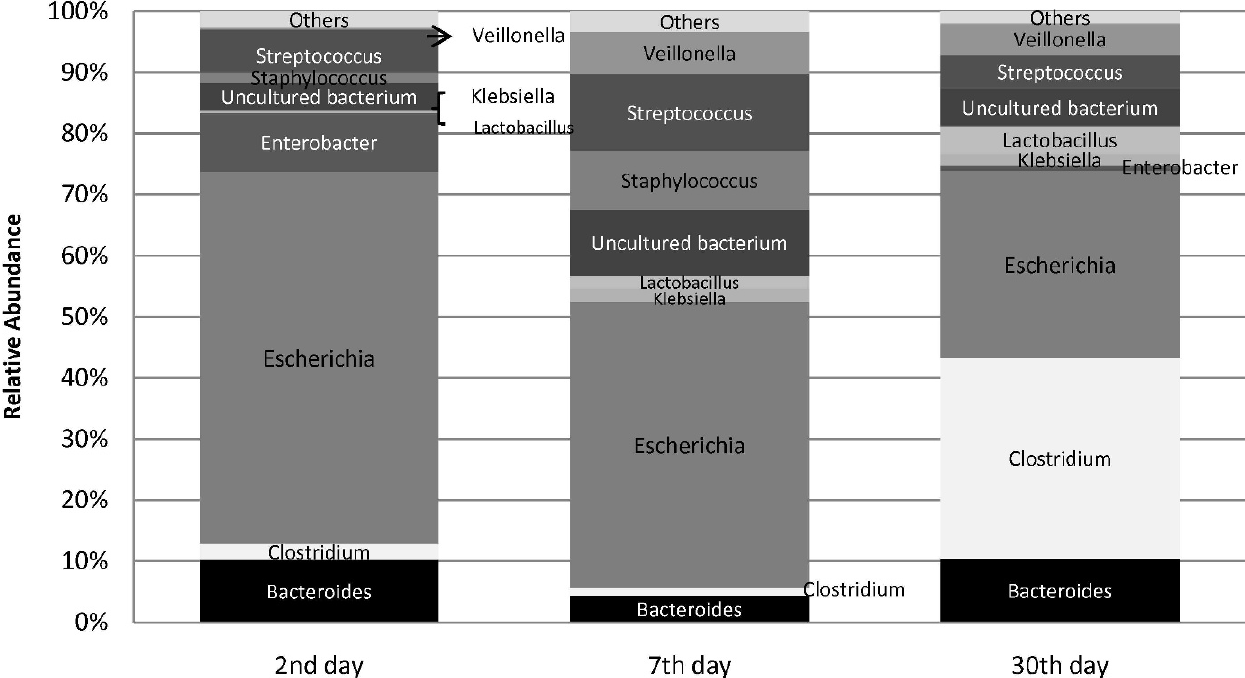
Figure 1 - Bacterial profile of the 16S rRNA library constructed with fecal samples from a group of nine neonates who were not given antibiotics. The sequences were grouped into genera. The data shown are pooled per time point.